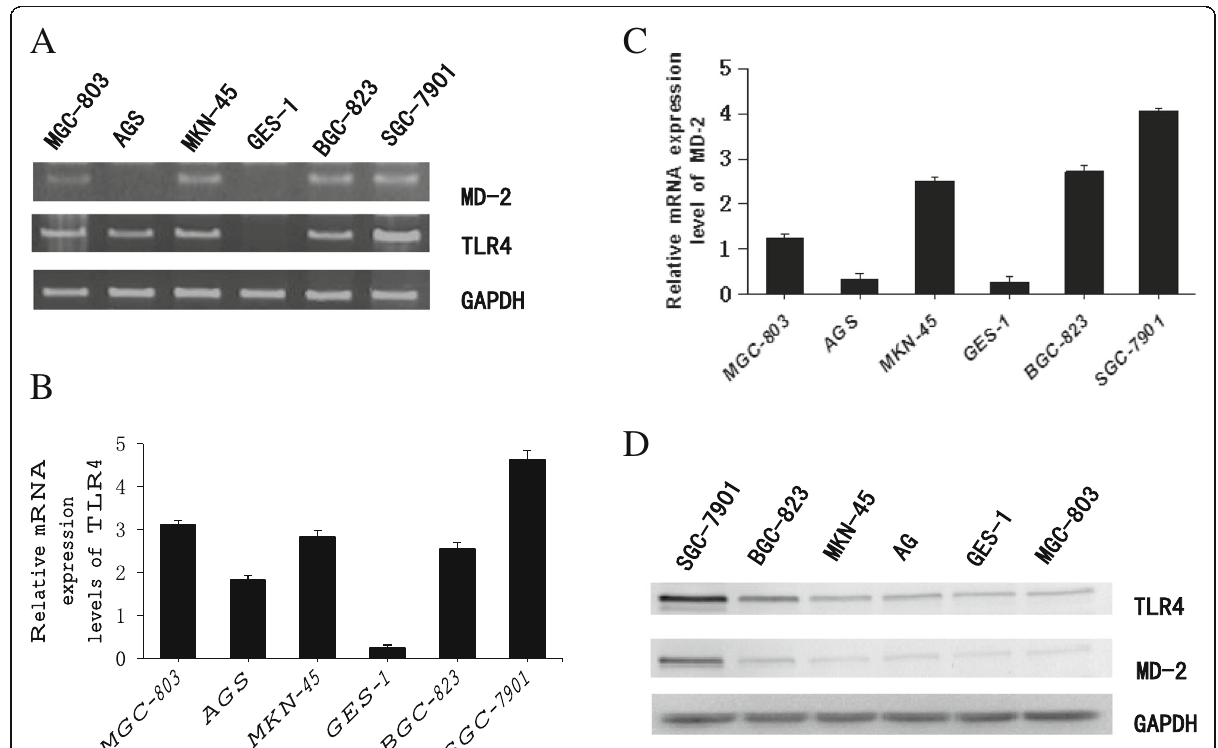
Fig. 1 TLR4 and MD-2 expression in gastric cancer cell lines. The expression of TLR4 and MD-2 was analyzed via RT-PCR ( a ), qRT-PCR ( b, c ) and western blotting ( d ) in gastric cancer cell